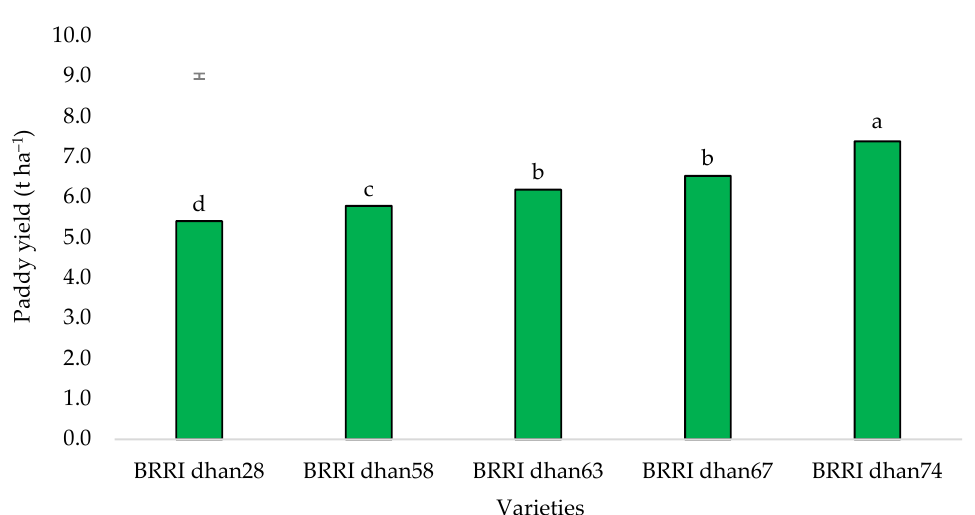
Figure 6. Effect of rice varieties on the paddy yield. The means with similar letters do not differ significantly at p ≤ 0.05.